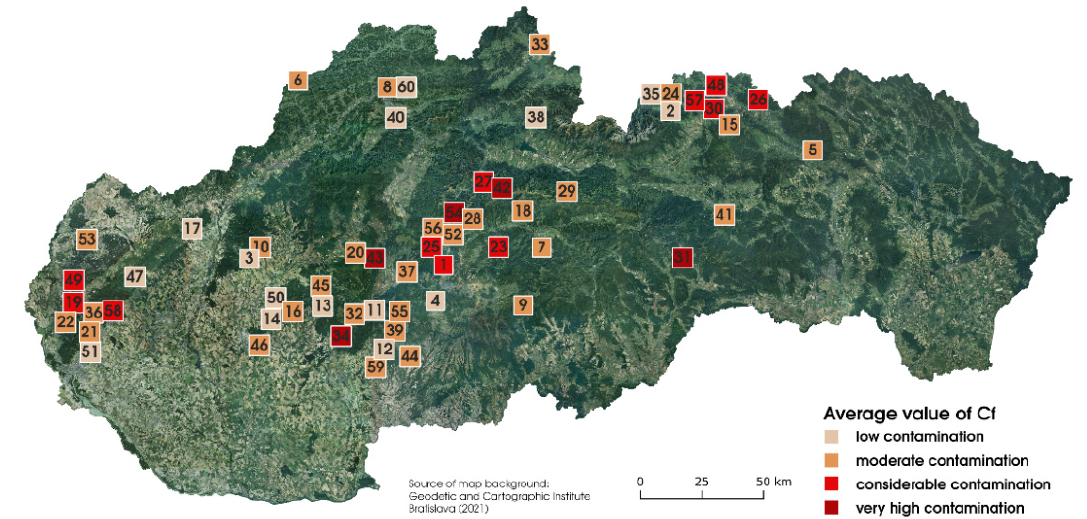
Figure 2. Soil pollution at the sampling localities expressed by contamination factor ( Cf ).